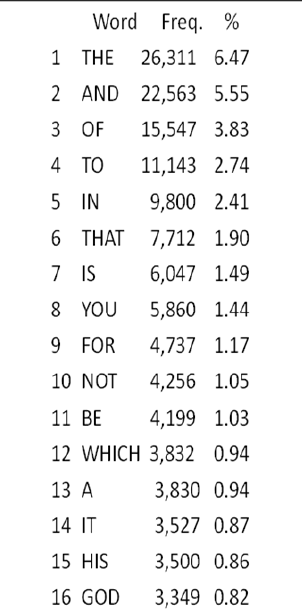
Religions 2018 , 9 , x FOR PEER REVIEW 12 of 24